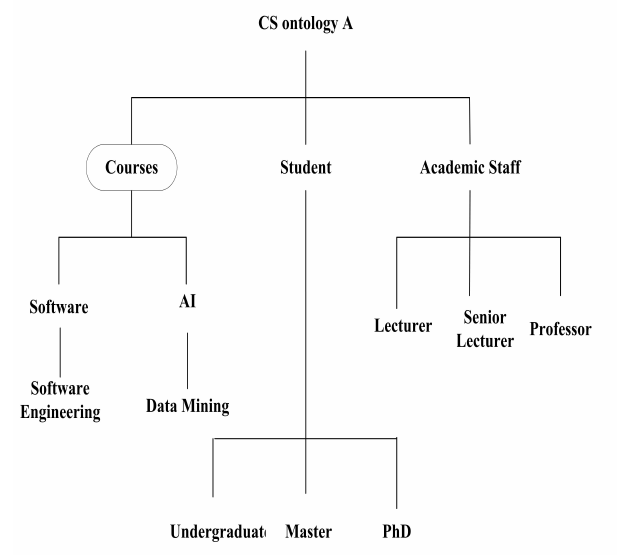
Fig. 7 “University” Ontology O 7